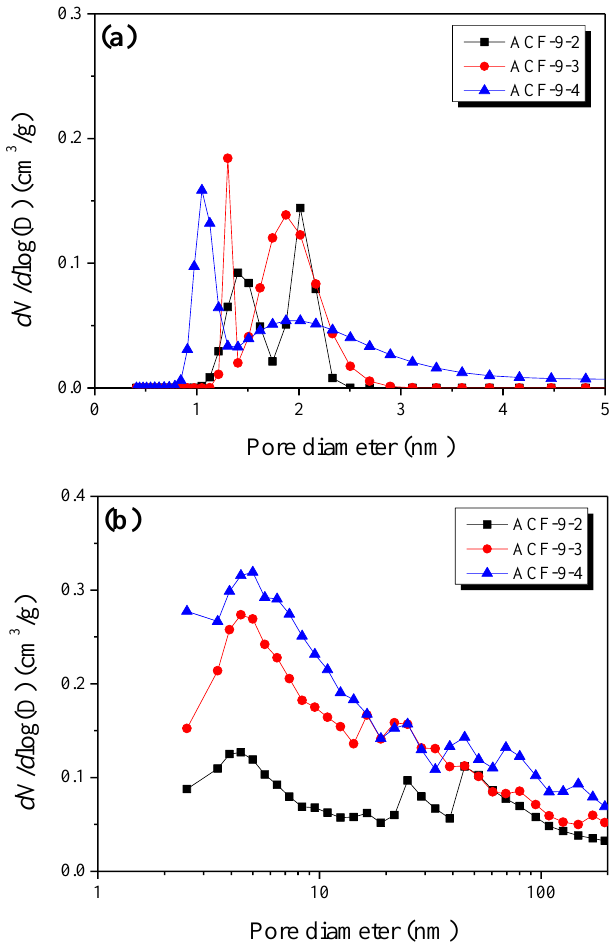
Figure 9. Pore size distribution curves of LLDPE-based activated carbon fibers as a function of acti- vation time: ( a ) micropore, ( b ) mesopore. PE-based ACF exhibited a longer breakthrough time than FM10 but a shorter satura- tion time (Table 5 and Figure 10). The acetaldehyde adsorption capacity of ACF-9-4 was 1.27 mg/g, which was observed to be about 164% of the acetaldehyde adsorption capacity of FM10. On the other hand, FM10 has more breakthrough capacity because the slope of the breakthrough curve is lower than that of ACF-9-4. In many previous studies, the acet- aldehyde adsorption capacity was found to be highly correlated with the micropore vol- ume of the adsorbent [30]. The values obtained by dividing the adsorption capacity by each micropore volume were confirmed to be 2.12 and 1.75, respectively. This means that the micropore volume is not the only factor determining the acetaldehyde adsorption ca- pacity of the ACFs, but that the nature of the precursor or manufacturing can also affect their adsorption ability. Therefore, ACF-9-4 is considered to have a higher acetaldehyde adsorption performance than FM10 because it has an advanced porous structure and ma- terial characteristics.